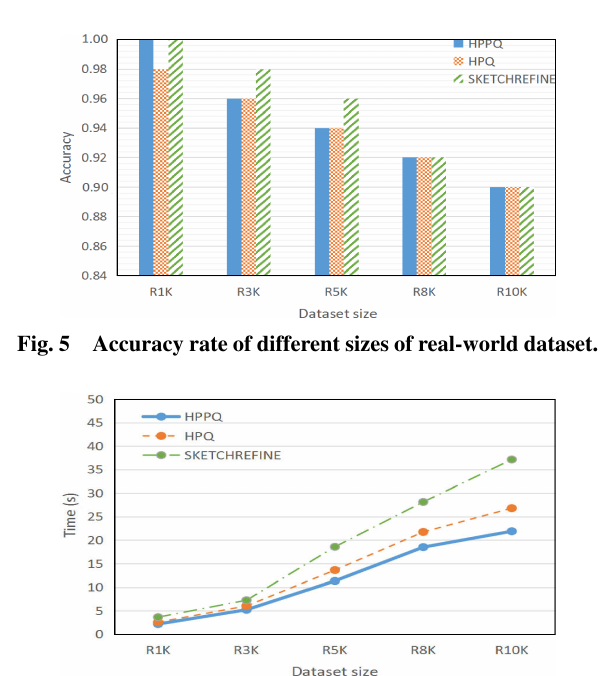
Fig. 6 Run time of different sizes of real-world dataset.